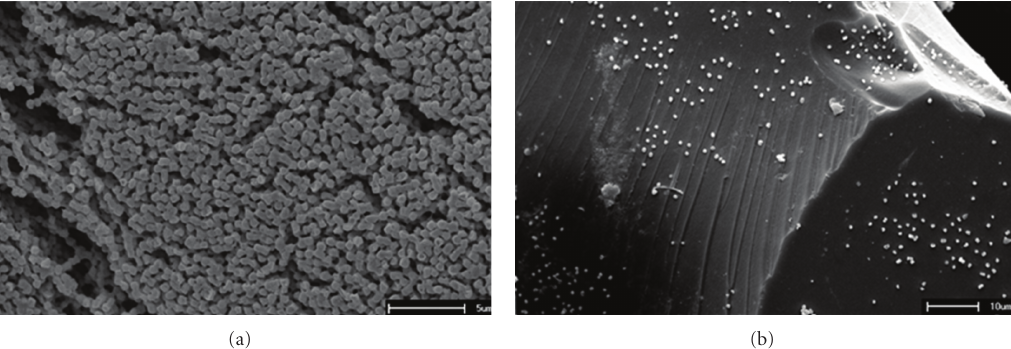
Figure 1: Scanning electron micrographs. (a) Free cells of Klebsiella oxytoca (3000x). (b) Immobilized cells on 6% SiO 2 /TiO 2 (1000x).